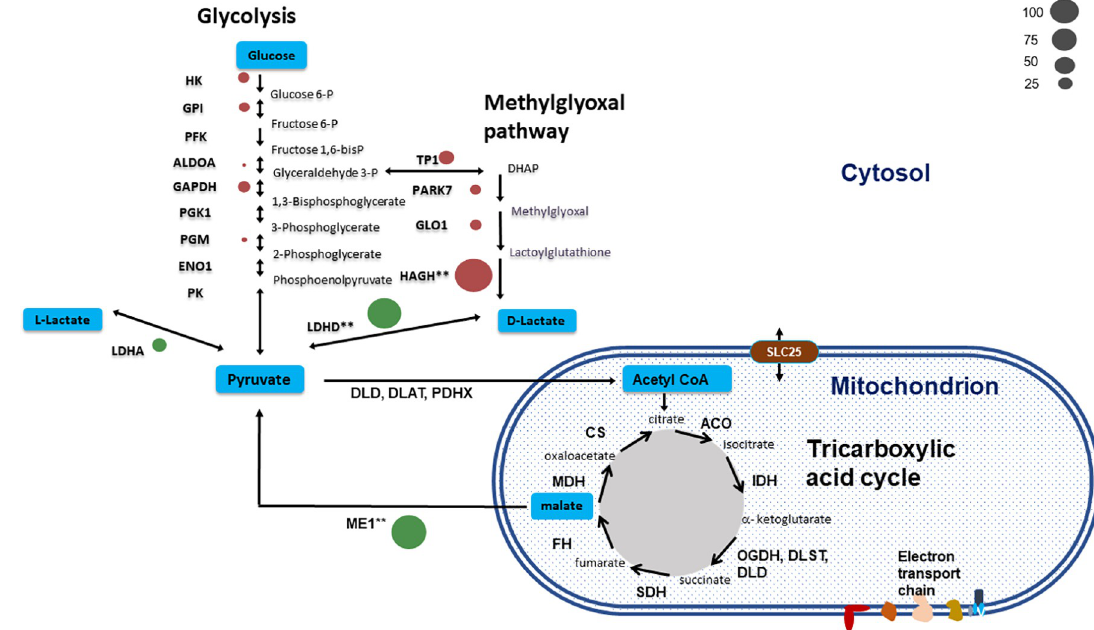
Fig 3. A diagram representing the enzymes involved in the 11 steps of the glycolytic and methylglyoxal pathway and tricarboxylic cycle found in the rumen epithelium of sheep. Significant fold change in proteins ( P < 0.05) is marked with a double asterisk ( �� ). Fold change is represented by bubble size and an increase in the abundance of an enzyme in the low CH 4 group shown by a green bubble, whereas increase in the abundance of an enzyme in the high CH 4 group shown by red bubble. Abbreviations of protein names: HK; hexokinase, GPI; glucose-6-phosphate isomerase, PFK; phosphofructokinase-1, ALDOA; fructose-bisphosphate aldolase, GAPDH; glyceraldehyde-3-phosphate dehydrogenase, PGK1; phosphoglycerate kinase, PGM; phosphoglycerate mutase, ENO1; enolase 1, PK; pyruvate kinase, LDHA; L-lactate dehydrogenase LDHD; D-lactate dehydrogenase, TPI1; triosephosphate isomerase, PCK2; pyruvate carboxykinase -2, P; phosphate. For enzymes involved in the TCA pathway and associated pyruvate or malate cycling. Abbreviations are DLAT; acetyltransferase, DLD; dihydrolipoyl dehydrogenase, PDHX; dihydrolipoamide acetyltransferase, CS; citrate synthase, ACO; aconitase, IDH; isocitrate dehydrogenase, OGDH; oxoglutarate dehydrogenase, DLST; Dihydrolipoamide S-succinyltransferase, FH; fumarate hydratase, MDH; malate dehydrogenase, ME1; malic acid enzyme, PCK2; pyruvate carboxykinase -2. ALAT; alanine aminotransferase; PAG; phosphate-activated glutaminase.